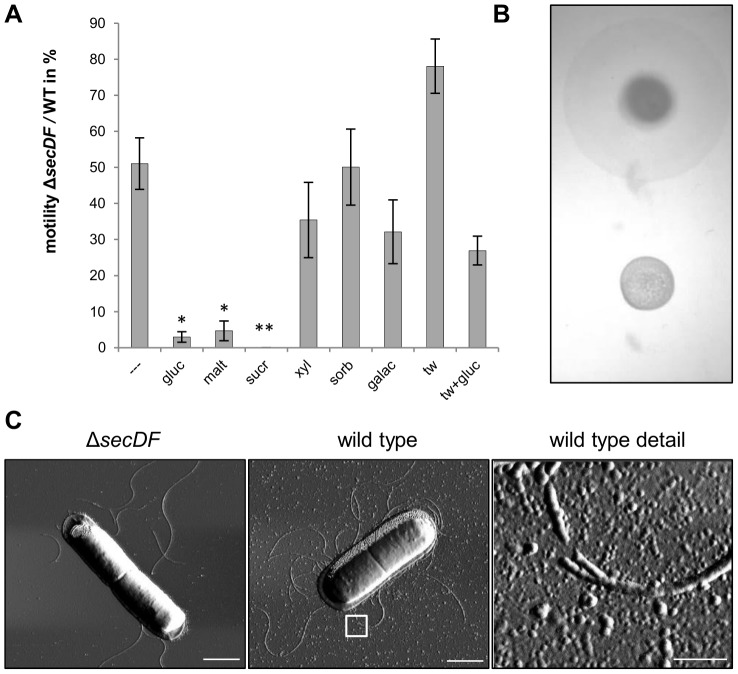
Diminished motility of the ΔsecDF mutant.
A) Motility of the ΔsecDF mutant compared to the wild type strain on 0.3% LB only —, or LB agar plates supplemented with: gluc, 0.4% glucose; malt, 1% maltose; sucr, 1% sucrose; xyl, 1% xylose; sorb, 1% sorbitol; galac, 1% galactose; tw, 0.02% Tween80, tw+gluc, 0.02% Tween80 and 0.4% glucose. The graph shows averages of four to ten independent experiments, error bars represent standard errors and an unpaired Students t-test with two-tailed distribution was performed between wild type and ΔsecDF mutant (all conditions P<0.05). A nonparametric ANOVA with Dunn's multiple comparison post hoc test was performed for “LB only” and each of the conditions using additives (*P<0.01; **P<0.001). No movement of the ΔsecDF mutant was recorded in LB+sucrose in four experiments. B) Comparison of motility on 0.7% LBG after 7 h incubation at 30°C; top: wild type; bottom: ΔsecDF mutant. C) AFM amplitude images representative of two independent experiments of cells grown in LBG for 4 h show the grade of flagellation and secretion of putative membrane vesicles. Bars: 1 µm in whole cell images; 0.2 µm in the wild type detail image indicating putative vesicles (arrows).